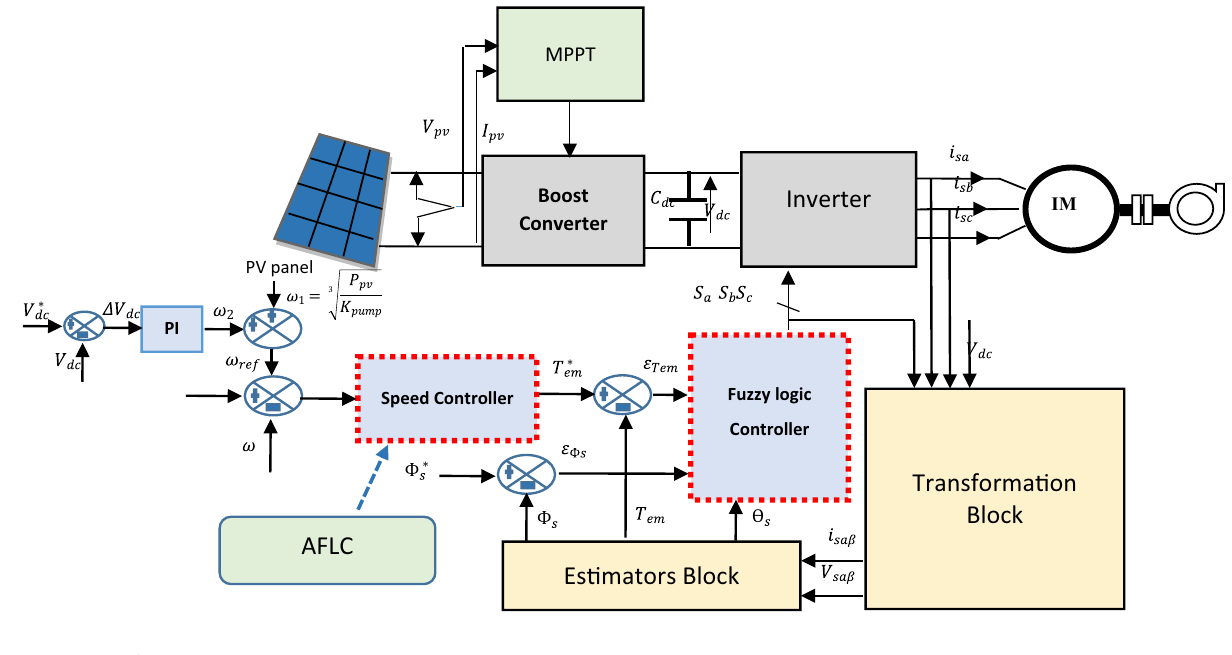
Fig. 1 Proposed PV water pumping system